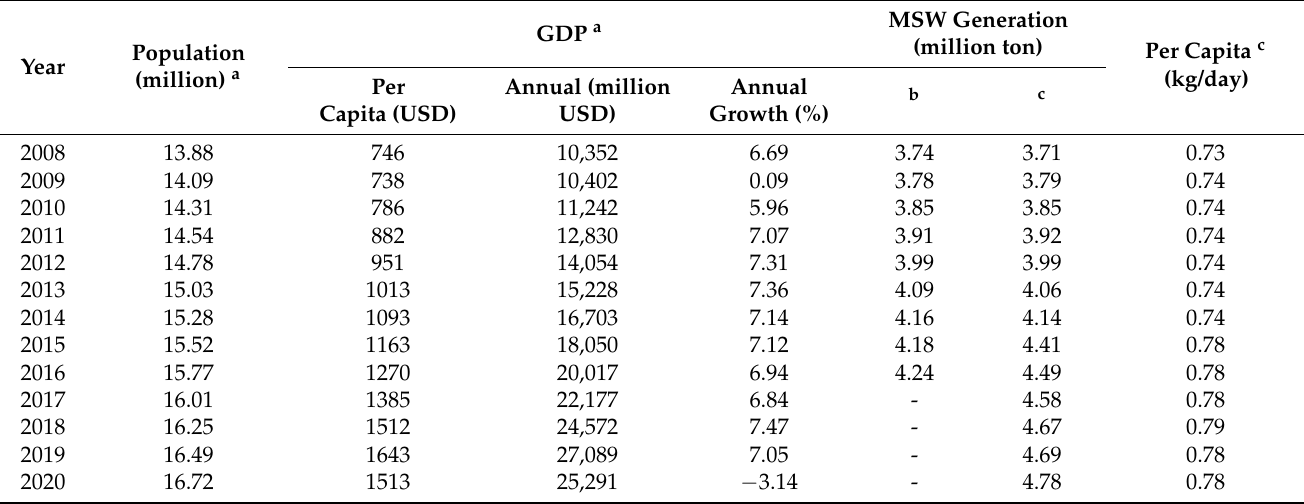
Table 1. Estimation of MSW generation based on population for